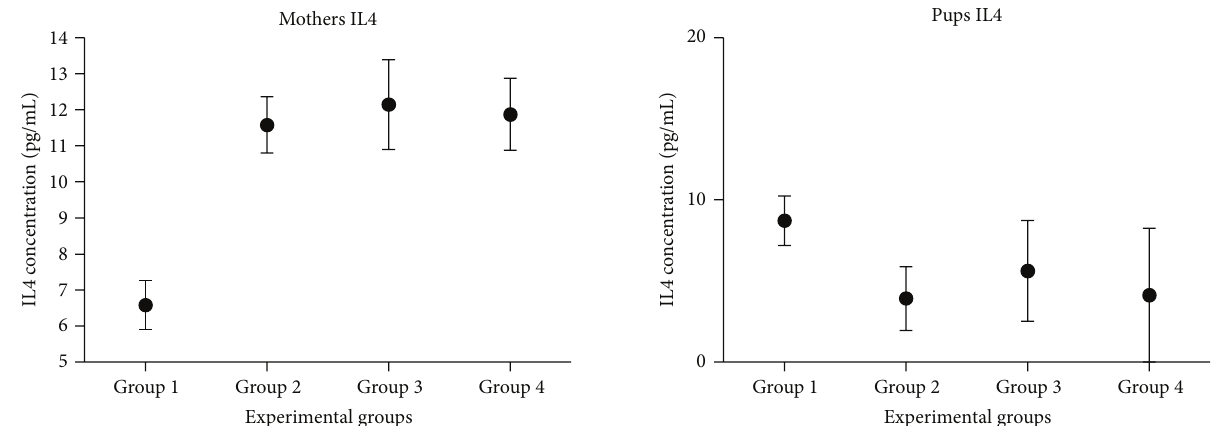
Figure 11: Quantification of interleukin 4 in the serums of mothers and pups. In the 𝑥 -axis, the different experimental groups are displayed; in the 𝑦 -axis, the average concentration of IL4 in pg/mL is represented.